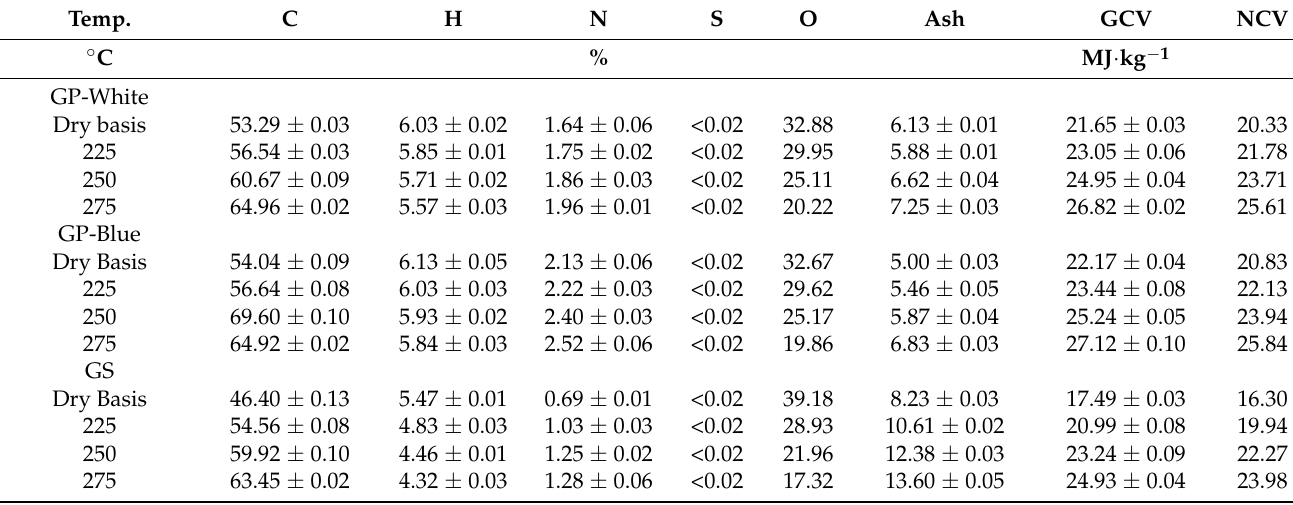
Table 1. Composition of grape pomace (GP) and grape stalk (GS) before and after torrefaction treatment at varying temperatures and 30 min residence time.